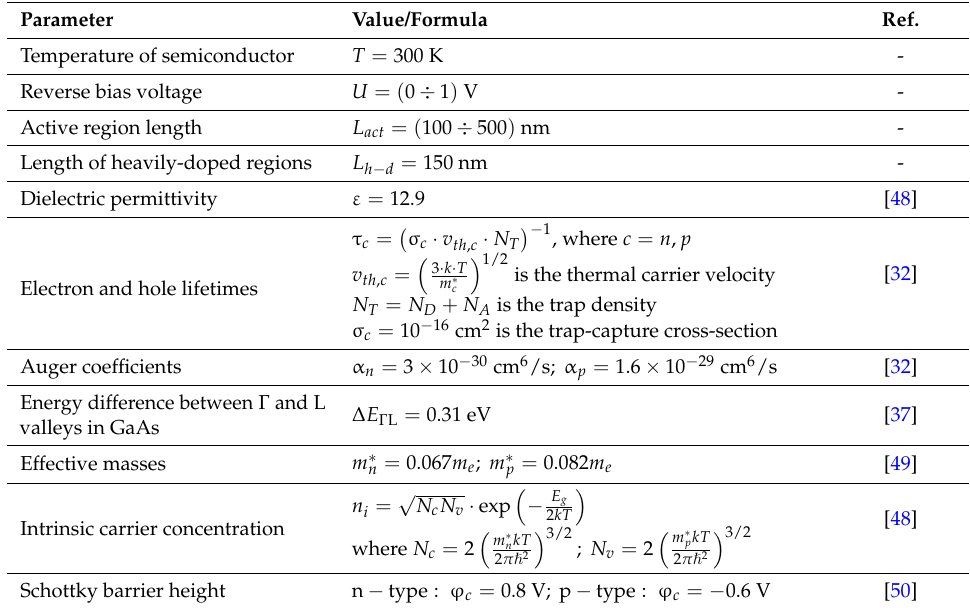
Table 2. Parameters used in the